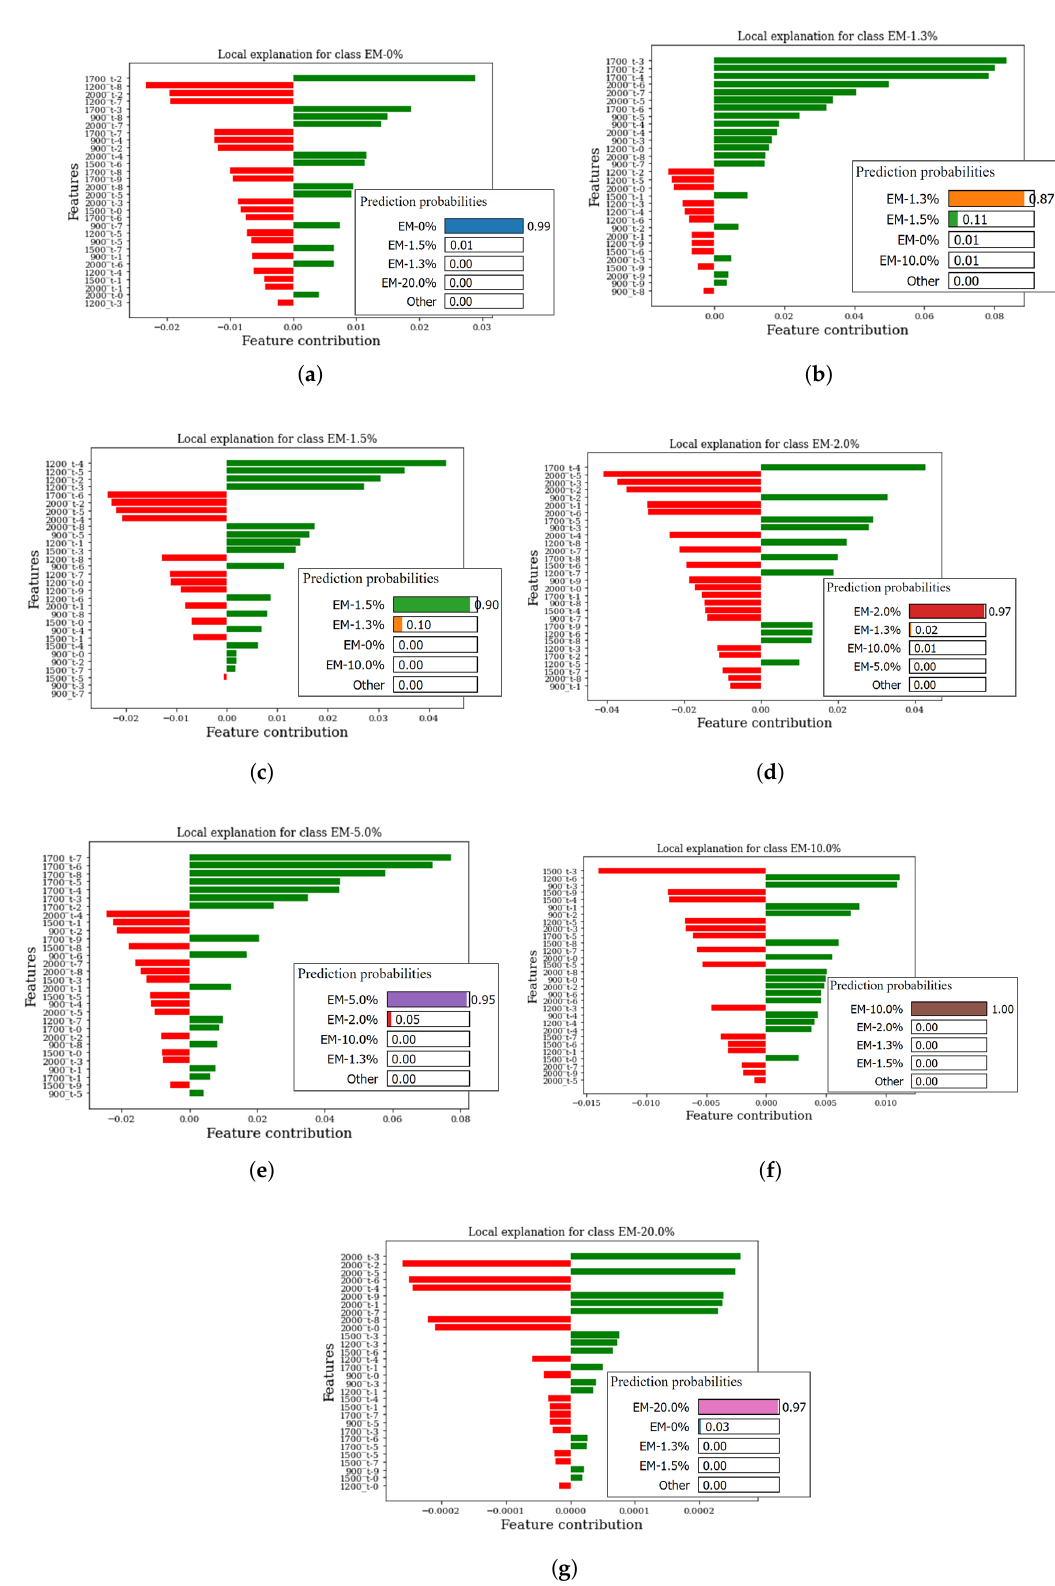
Figure 10. LIME-based explanations, faithfulness, and feature importance/contributions for the proposed model predictions on samples of the different emulsion compositions. ( a ) EM-0%, ( b ) EM-1.3%, ( c ) EM-1.5%, ( d ) EM-2.0%, ( e ) EM-5.0%, ( f ) EM-10.0%, and ( g )